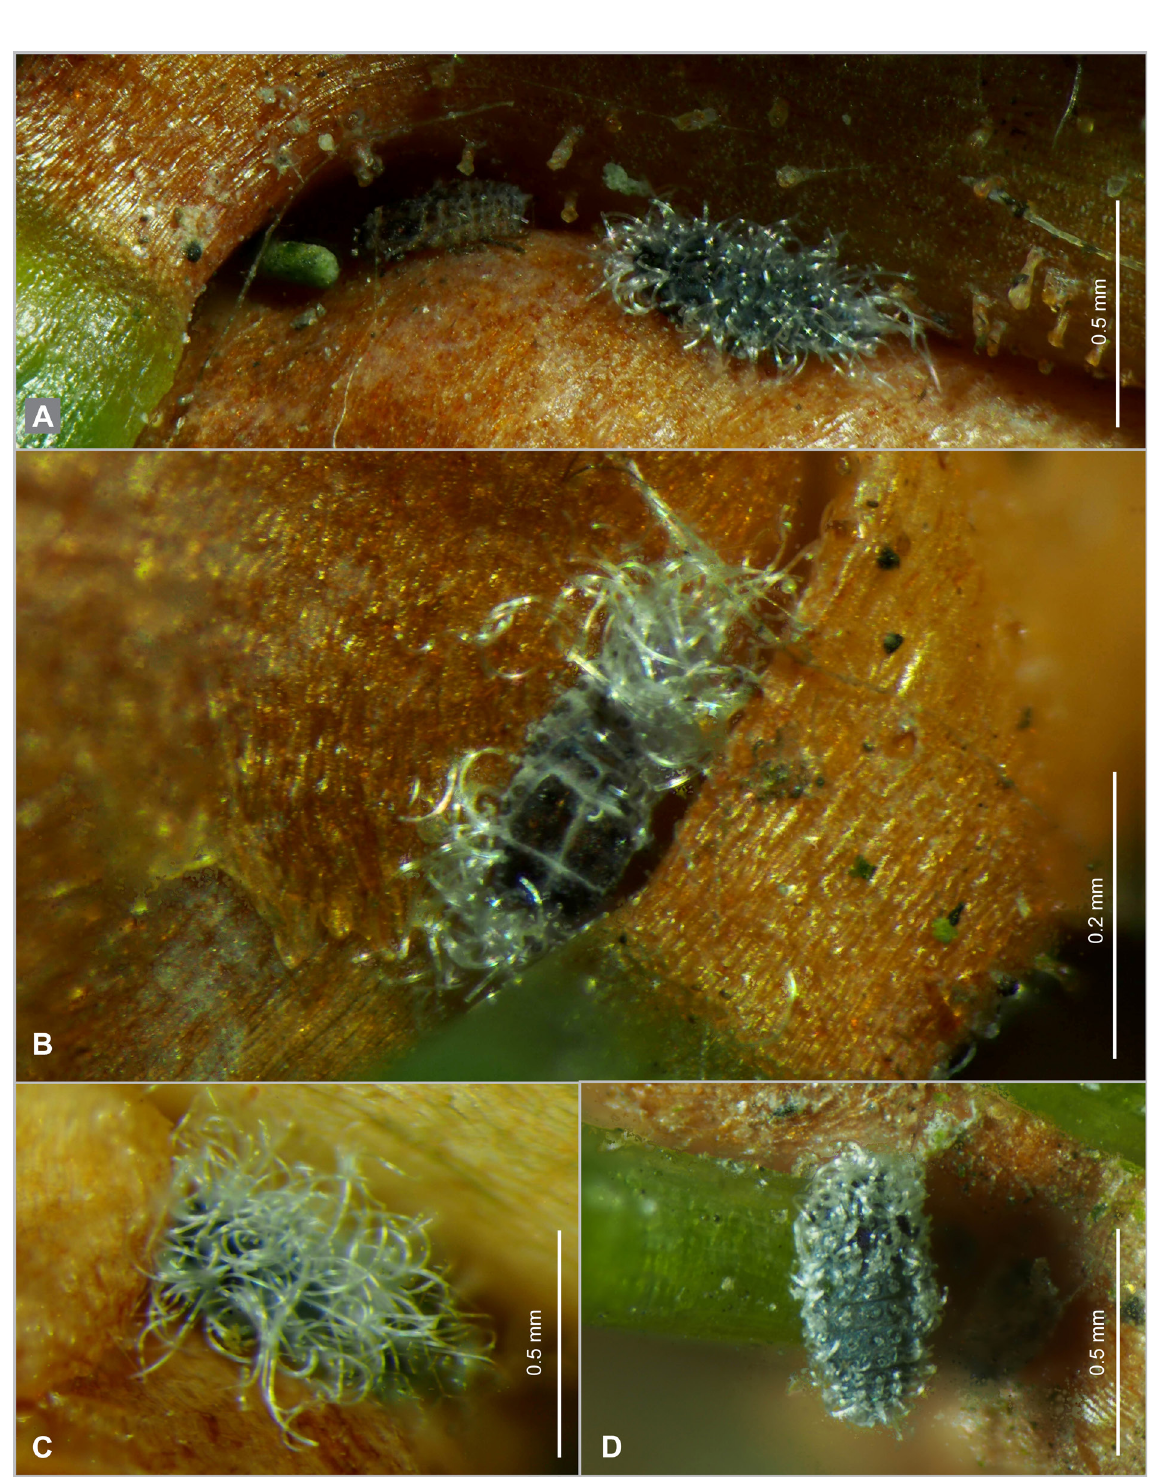
Fig. 20. Adelges (Sacciphantes) abietis (Linnaeus, 1758) on Picea abies in winter. A . First instar exuvium and second instar nymphs. B . First instar exuvium. C–D . Second instar nymphs, in D with wax filaments worn